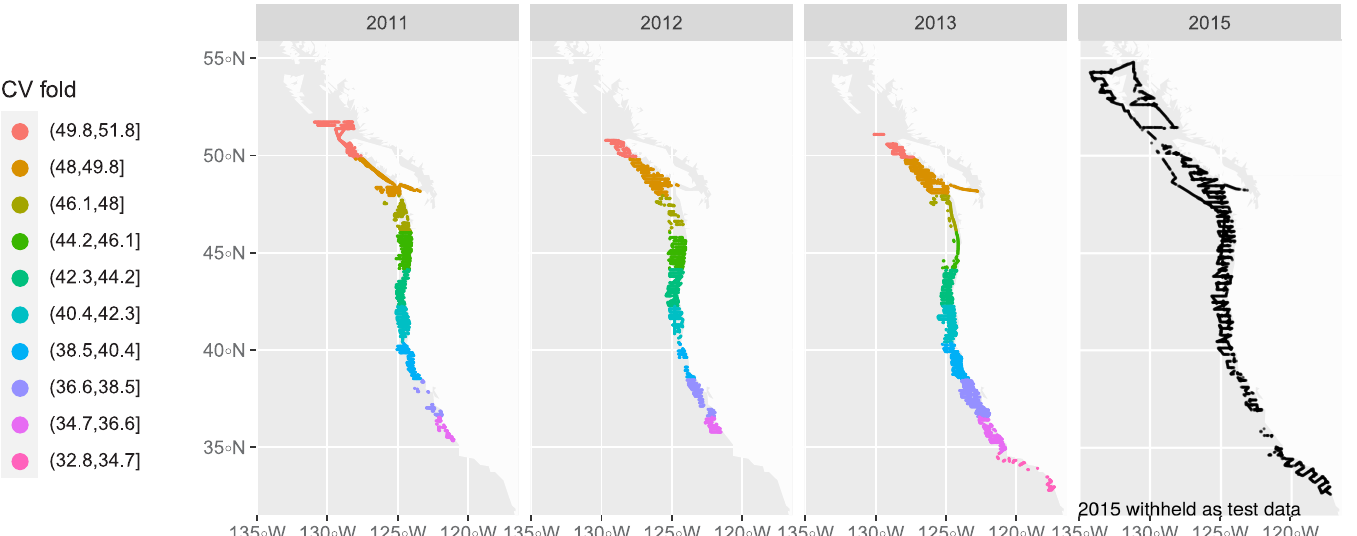
Fig 1. Acoustic data coverage by year. Color represents the ten cross validation (CV) folds that correspond to latitudinal bins. Each point represents a spatial location along a trackline where data were collected. The 2015 points are black, and represent a withheld test set that was not used in spatial cross validation.